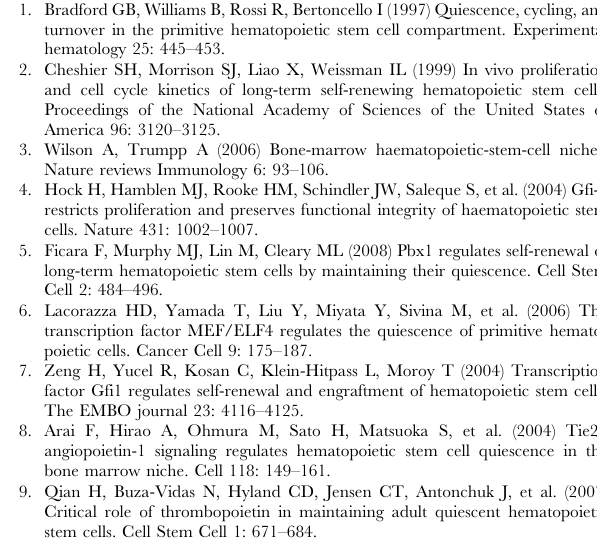
Table S1 The list of genes differentially expressed between Meis1-deficient and –sufficient LSK cells. Table S2 The list of primers for